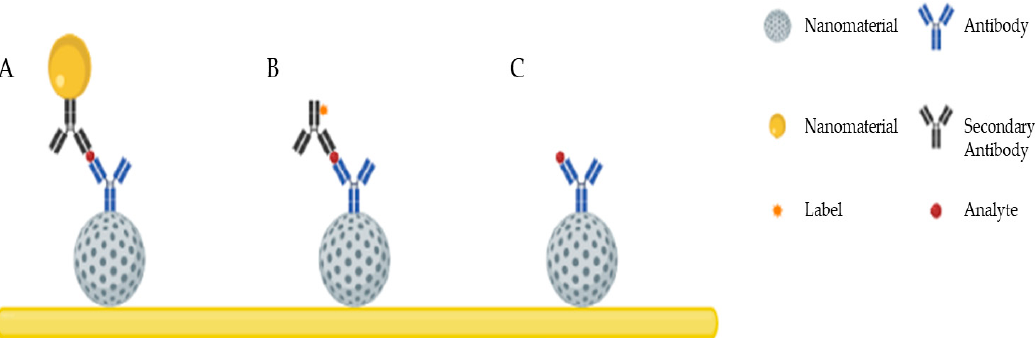
Figure 1. Schematic illustration of the most common detection schemes developed using nanomaterials: ( A ) sandwich assay with secondary antibodies conjugated with nanomaterials and without labels; ( B ) sandwich assay with labeled secondary antibodies; ( C ) direct detection.